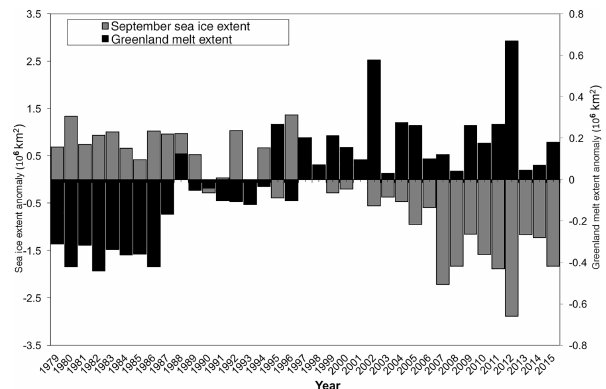
Figure 1. Time series of September sea ice extent and Greenland surface melt extent anomalies from 1979 to